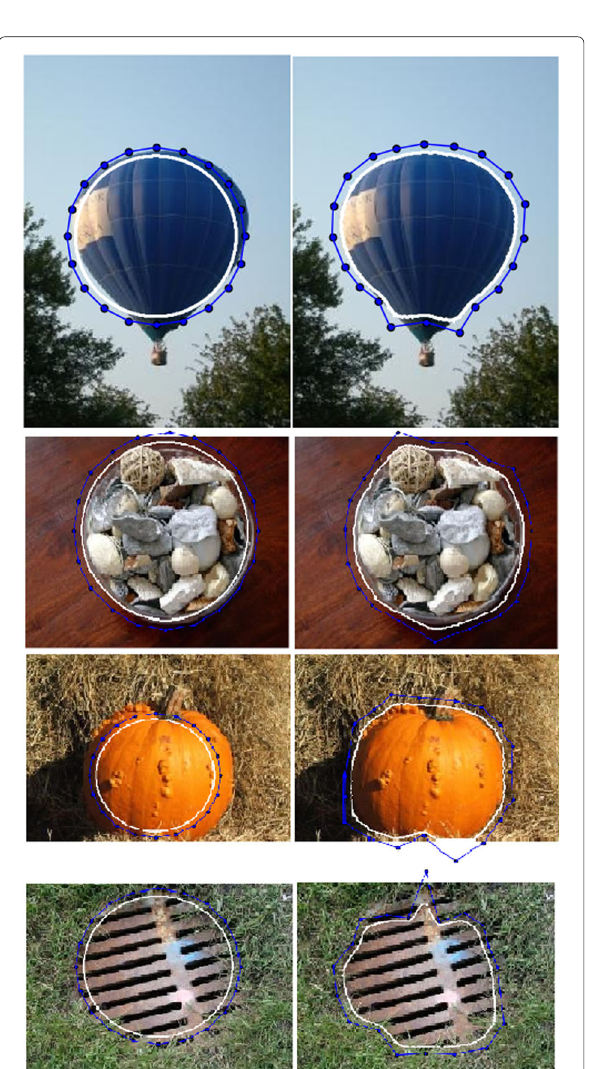
Fig. 5 Segmentation results. First column: initial contour (continuous white circle) and cage (polygon with 20 points). Second column: resulting contour (continuous white closed curve) and cage (deformed polygon) using the multivariate Gaussian mixture energy function. In the second column, image sizes have been scaled so as to show all cage points